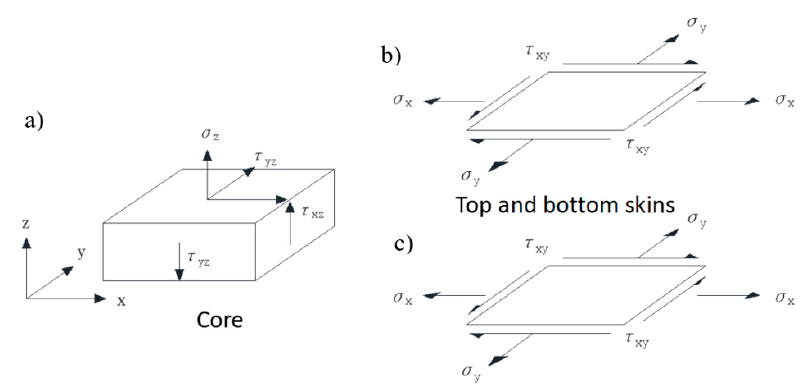
Figure 5. Stress diagram of honeycomb sandwich structure: ( a ) core; ( b ) top skin; ( c ) bottom skin.